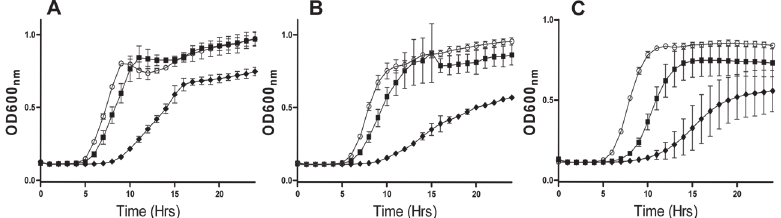
Fig 2. Growth curve analysis of strains in nisin A and nisin I4V peptides. (A) S. pseudintermedius DSM21284 in 0.26 mg/L of nisin A (closed square), I4V (closed diamond) and no peptide (open circle), and (B) S. pseudintermedius DK729 in 0.52 mg/L of Nisin A (closed square), I4V (closed diamond) and no peptide (open circle) and (C) S. intermedius DSM20373 in 0.52 mg/L of Nisin A (closed square), I4V (closed diamond) and no peptide (open